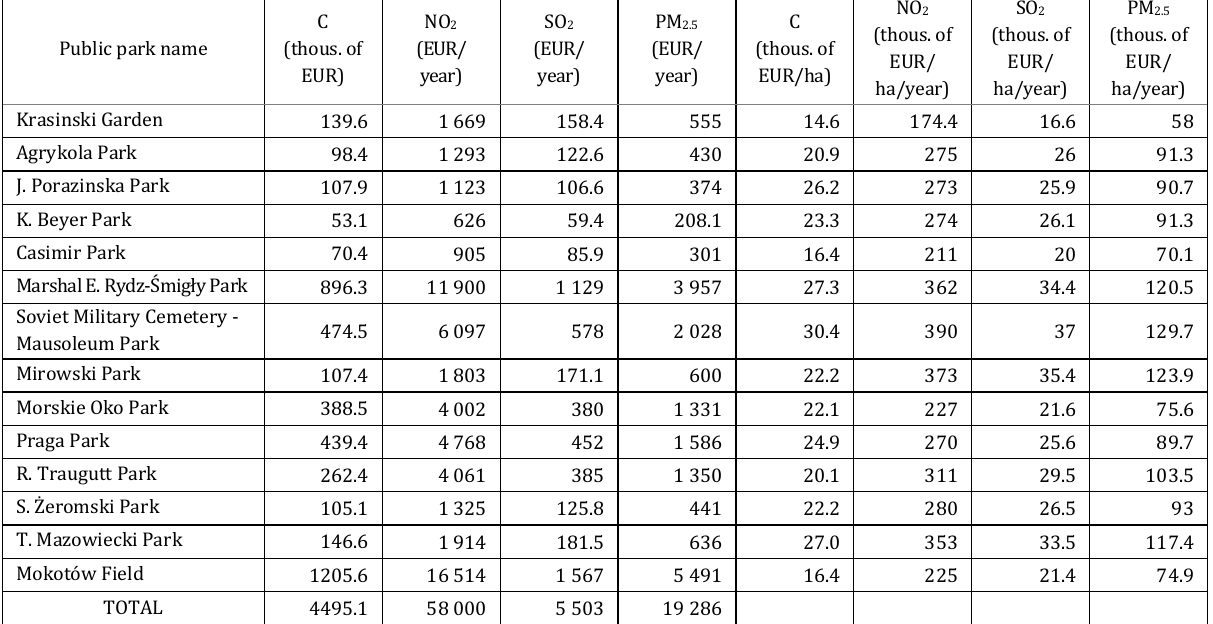
Table 4. Economic value of the analyzed ecosystem services across 14 public parks in Warsaw